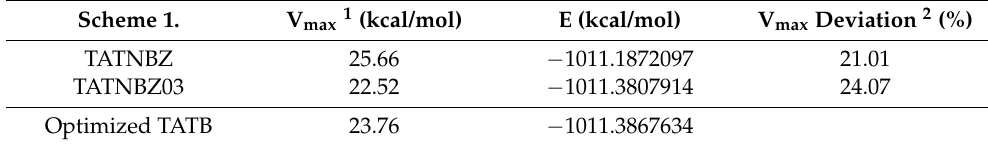
Table 4. Total energies, V max deviations and V max values in critical points above the centers of nitroaromatic rings calculated for selected crystal structures containing TNT molecule. Scheme 1.